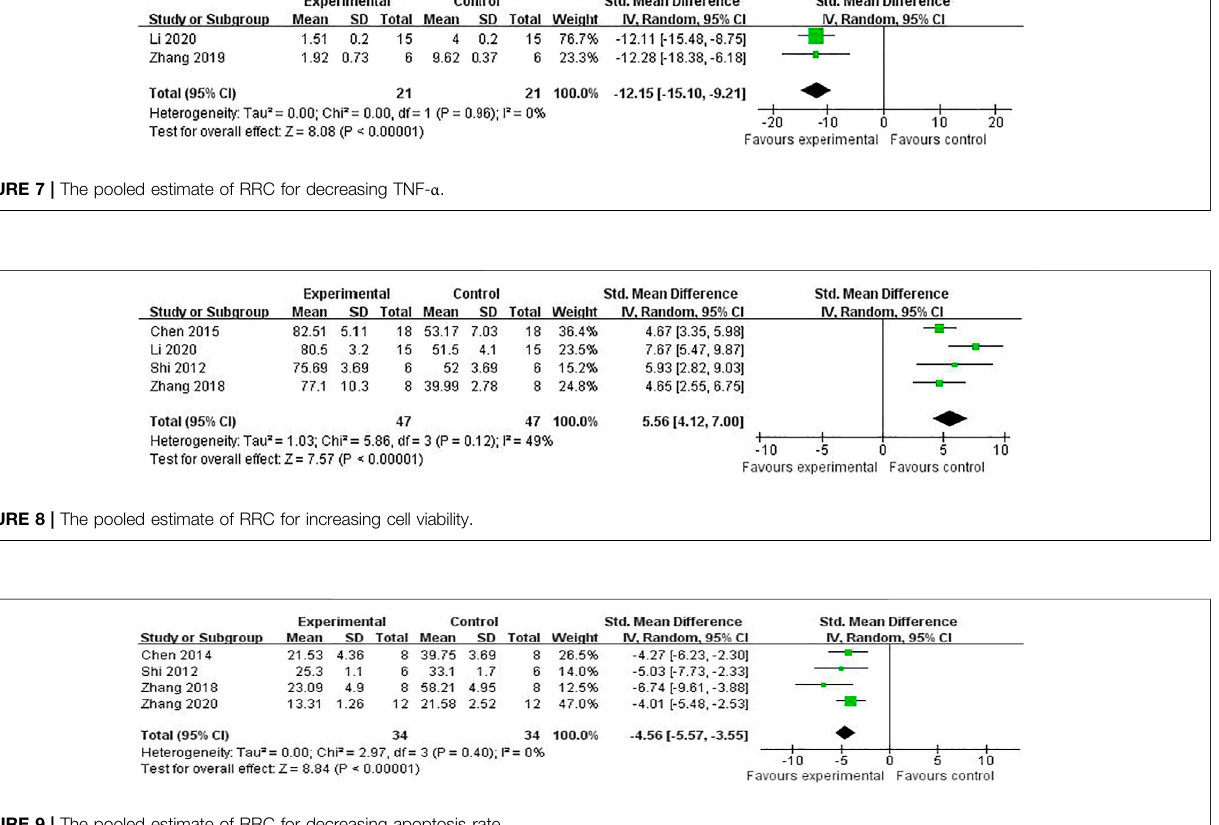
FIGURE 9 | The pooled estimate of RRC for decreasing apoptosis